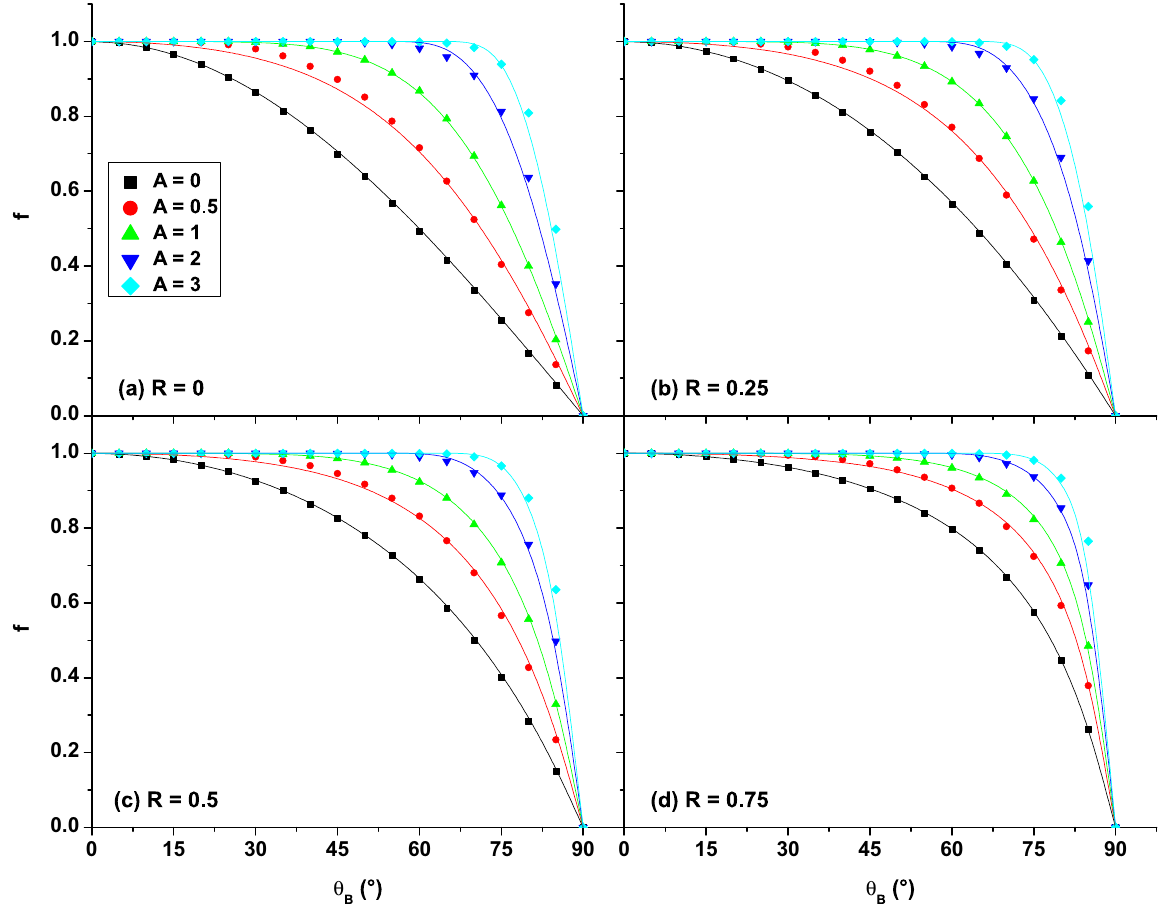
Figure 4. Dependence of the relative SEY on the magnetic field angle θ B , for different values of the reflection coefficient R and different values of the parameter A . Symbols correspond to MC simulations, full lines correspond to Eq. (13). The legend in ( a ) is valid for all